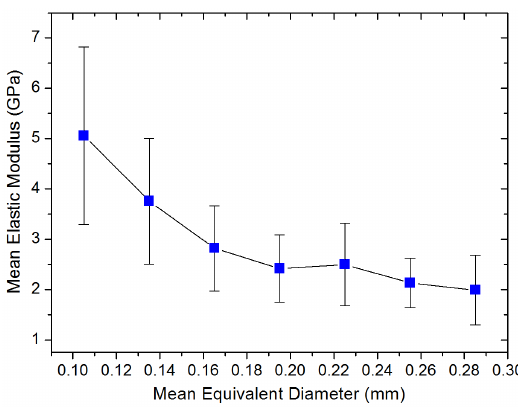
Figure 6. Variation of the Weibull average elastic modulus with the mean equivalent diameter for each interval in Figure 3. Source: